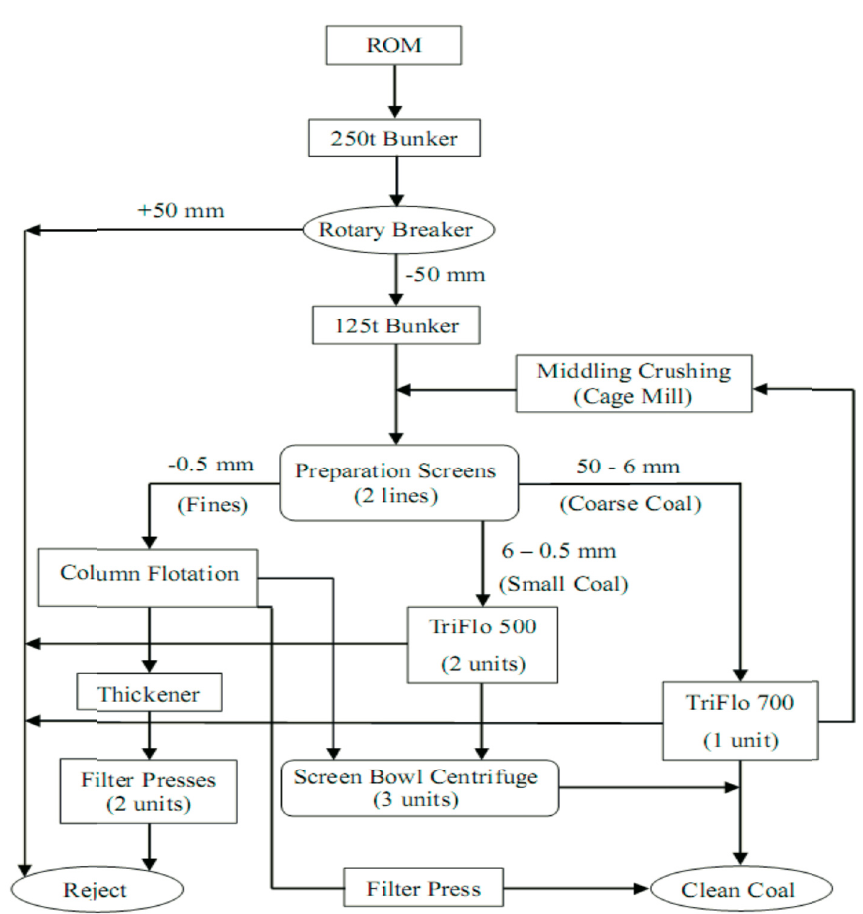
Fig. 2. The process flowsheet of the Tabas Coal Preparation Plant (TCPP)